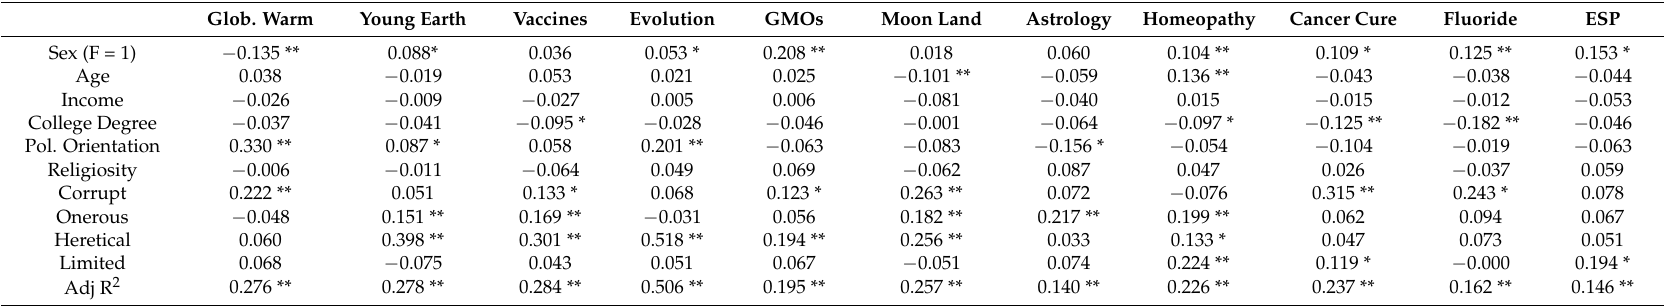
Table 6. Multiple regression models predicting anti-science beliefs from demographics, political and religious orientation and NPSS (standardized betas from full model shown